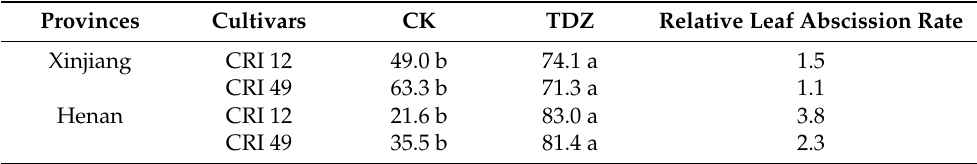
Table 4. Leaf abscission rate between CRI 49 and CRI 12 in the field. Provinces